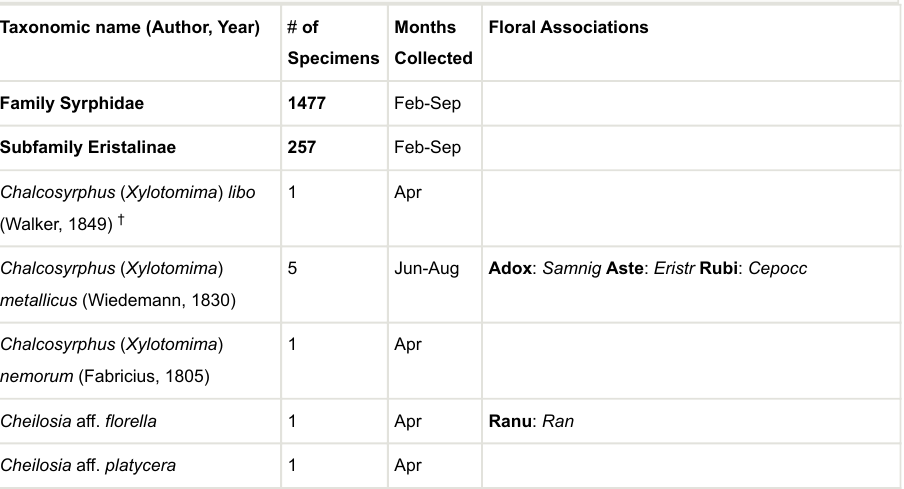
Table 1. List of syrphid species collected in Randolph county and the southernmost 11 counties of Illinois, United States, from 2017-2019 with number and date range of specimens collected. Floral associations are reported for each species and correspond to family and species codes given in Table 2. Taxa with no floral associations listed were collected only from pan traps and/or free flying. Full occurrence records are provided in Suppl. material